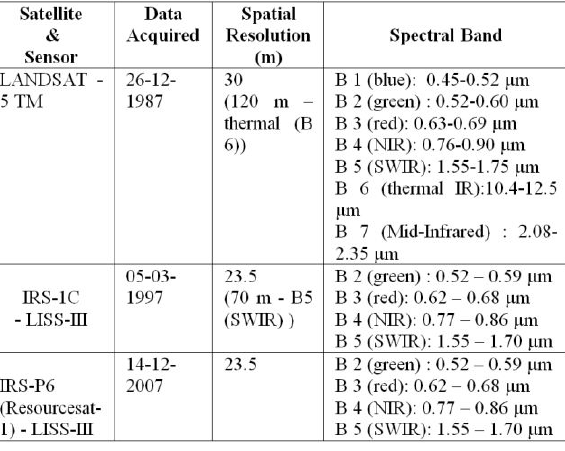
Table 1: Details of satellite data used in the study